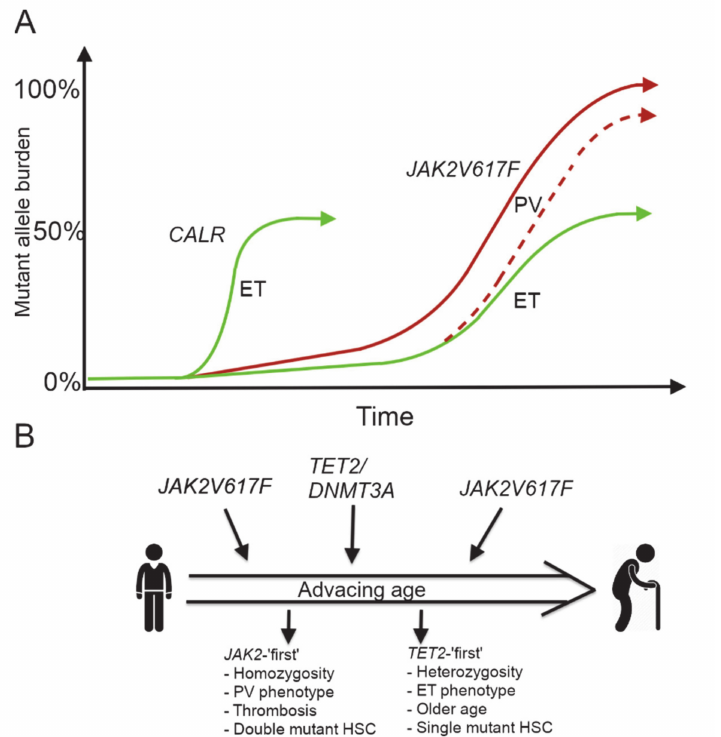
Figure 2. Expansion of the MPN clone is a ff ected by both the type of phenotypic driver and co-mutation acquisition order. ( A ) The CALR allele burden is considered to expand rapidly but homozygosity is rare and is virtually always associated with the essential thrombocythemia (ET) phenotype (green curve to the left). Di ff erent disease trajectories are seen for patients carrying the JAK2V617F mutation. Homozygosity for the mutation arises frequently in patients, but a homozygous clone is more likely to become the dominant in patients diagnosed with polycythemia vera (PV) (red curve). The ET trajectory for patients carrying the JAK2V617F (green curve to the right) will occasionally progress into a PV phenotype indicating a ‘biological continuum’ from ET to PV (dashed red line). ( B ) The acquisition order of JAK2V617F relative to TET2 and DNMT3A influences the disease phenotype. If the JAK2V617F occur prior to TET2 this results in a more severe phenotype, with the homozygous JAK2V617F / TET2 clone becoming dominant, whereas TET2 first leads to a predominantly heterozygous phenotype, where the JAK2V617F clone is reluctant to outcompete the TET2 mutated